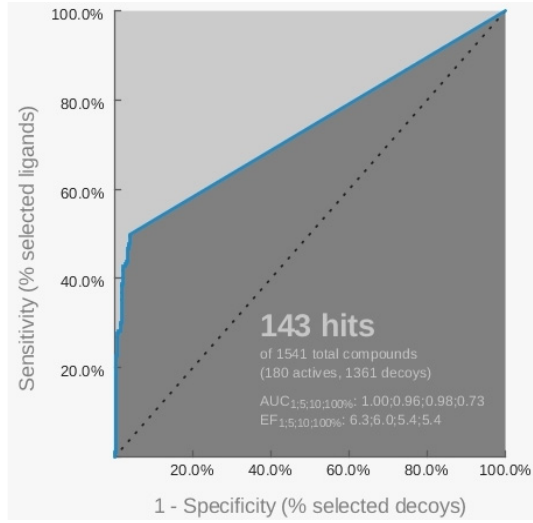
Figure 5. Representation of the ROC curve related to the pharmacophore H_9 generated starting from the 4FXM PDB model by LigandScout software.